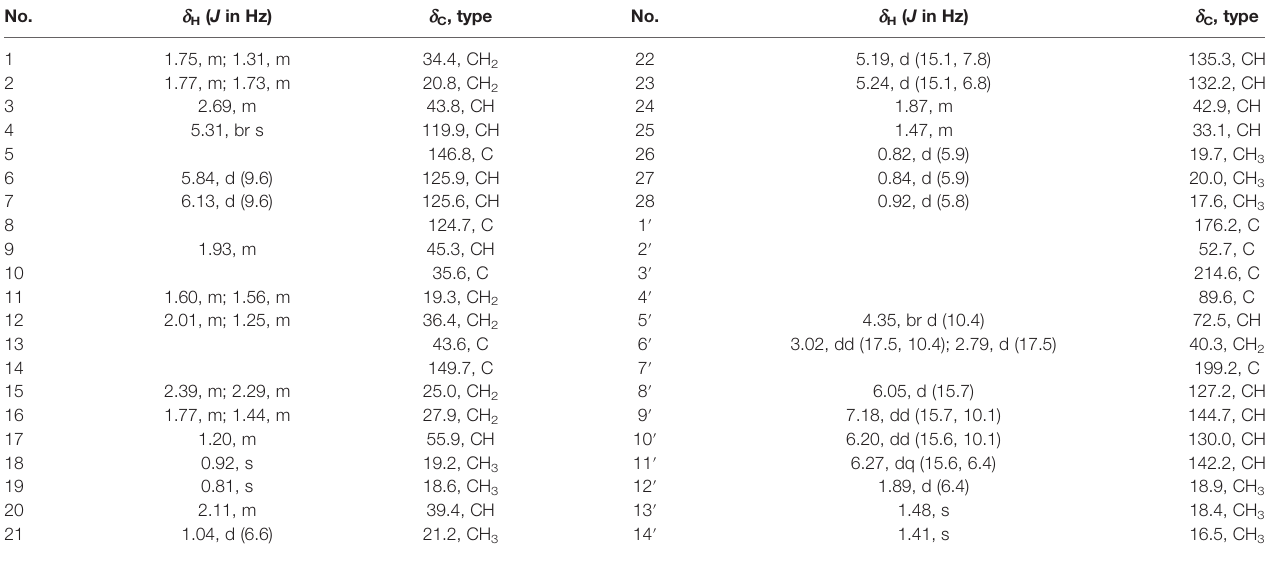
TABLE 1 | 1 H NMR (500 MHz, d in ppm) and 13 C NMR Data (125 MHz, d in ppm) for 1 (measured in CDCl 3